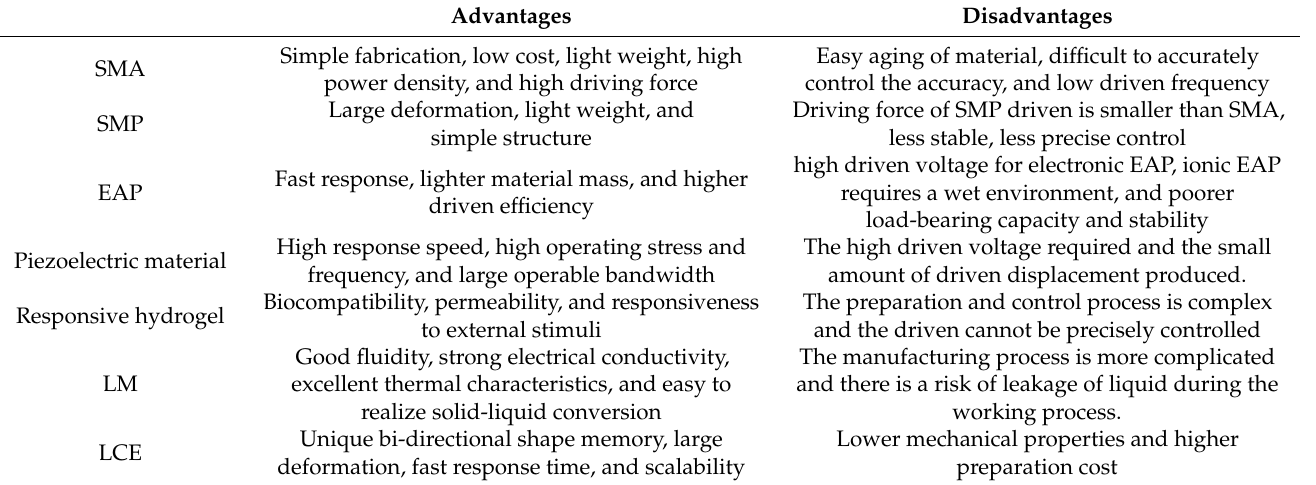
Table 1. Advantages and disadvantages of different smart